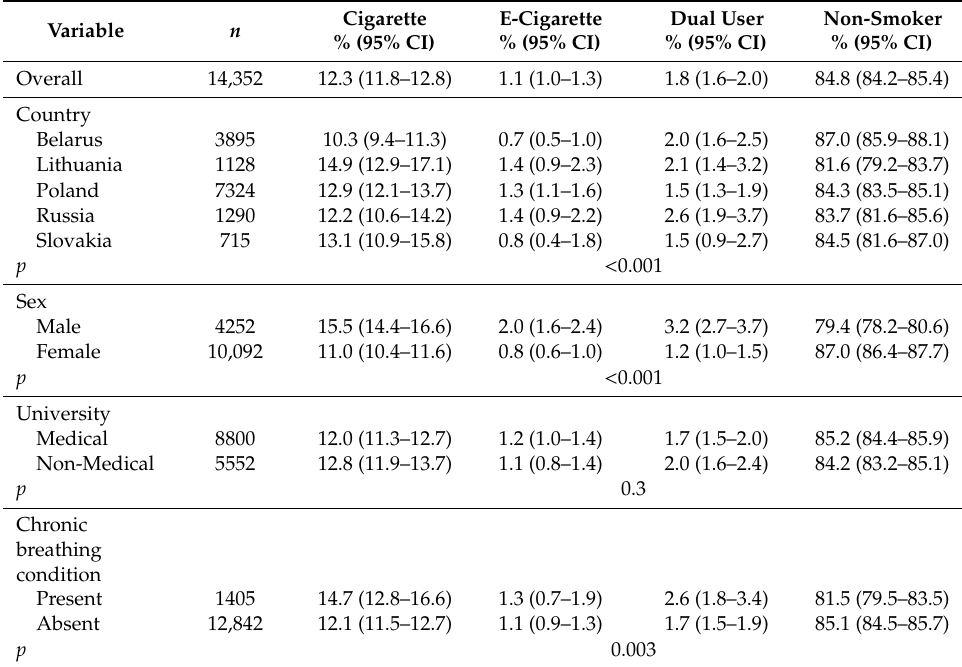
Table 3. Classification of smoking status by country of residence, sex, and university training.